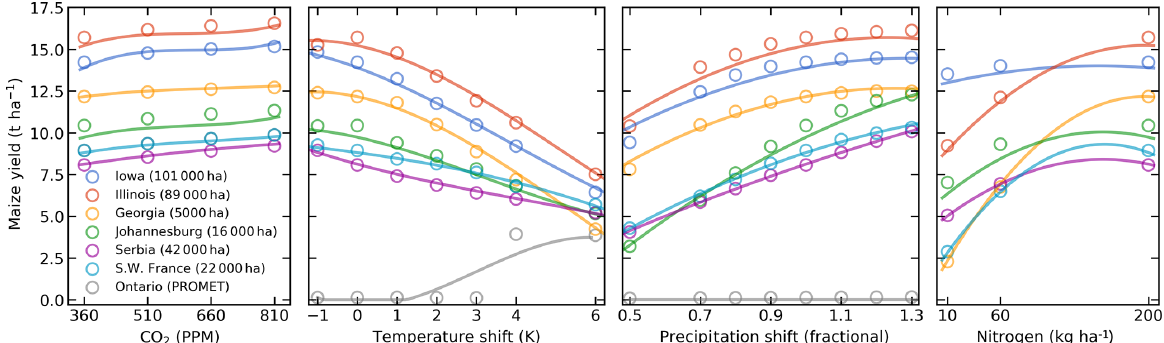
Figure 5. Illustration of spatial variations in yield response, which are successfully captured by the emulator. Panels show simulations (points) and emulations (lines) of rainfed maize in the pDSSAT model in six example locations selected to represent high-cultivation areas around the globe. Legend includes hectares cultivated in each selected grid cell. Each panel shows variation along a single variable, with others held at baseline values. Dots show climatological-mean yields and lines the results of the full 4-D emulator of Eq. (1). In general, the climatological response surface is sufficiently smooth that it can be represented within the sampled variable space by the simple polynomial used in this work. In some cases, extrapolation would produce misleading results, and the emulator fails in conditions where yield response changes abruptly. Failure is illustrated here by rainfed maize in north-central Ontario for the PROMET model (in gray), which shows present-day yields of zero rising abruptly if temperature warms by 4 ◦ C.